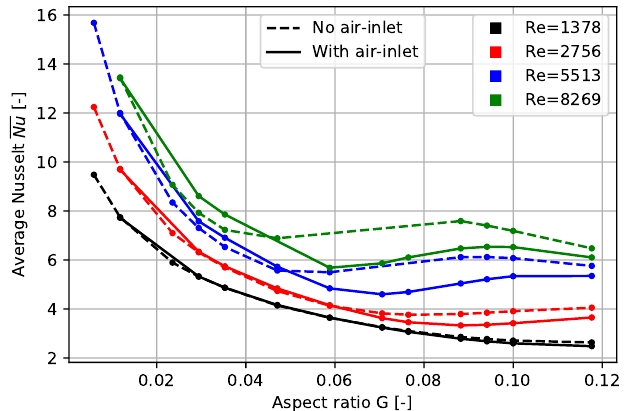
Figure 15. Influence of the gap-length aspect ratio, G, on the average Nusselt number. Use is made of two AFPM configurations, one with and one without an air-inlet for varying Reynolds